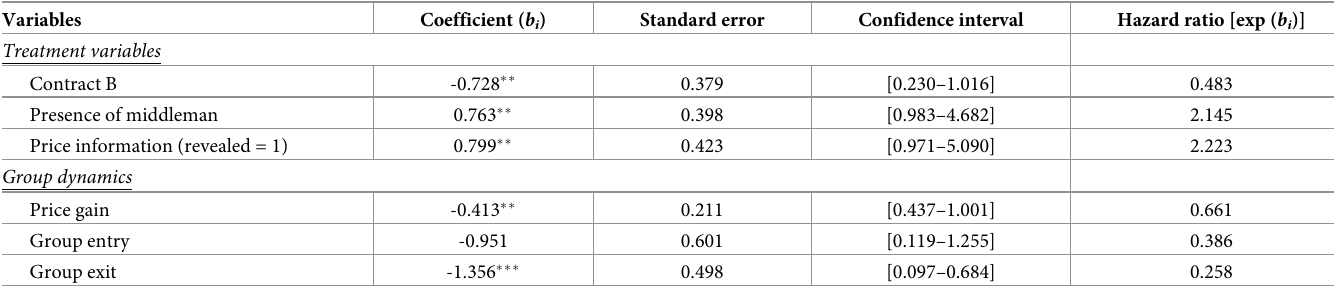
Table 7. Cox proportional hazard model for group survival ( n =